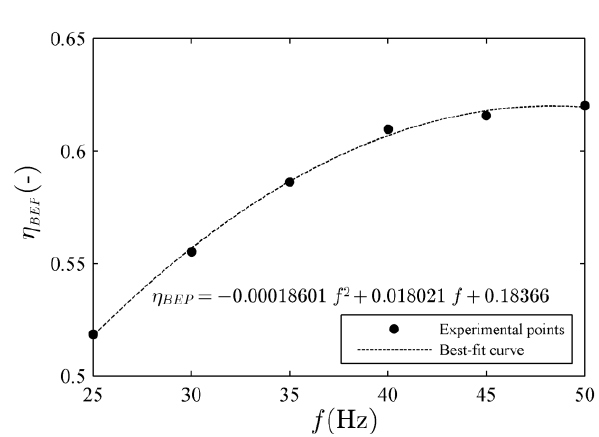
Figure 7. Best-fit polynomial curve of frequency against best efficiency point ( f vs η BEP